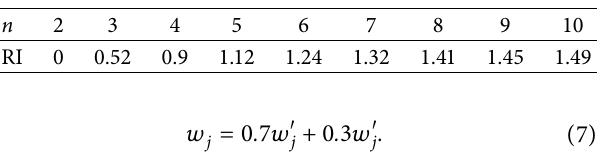
Table 3: Determination of matrix RI